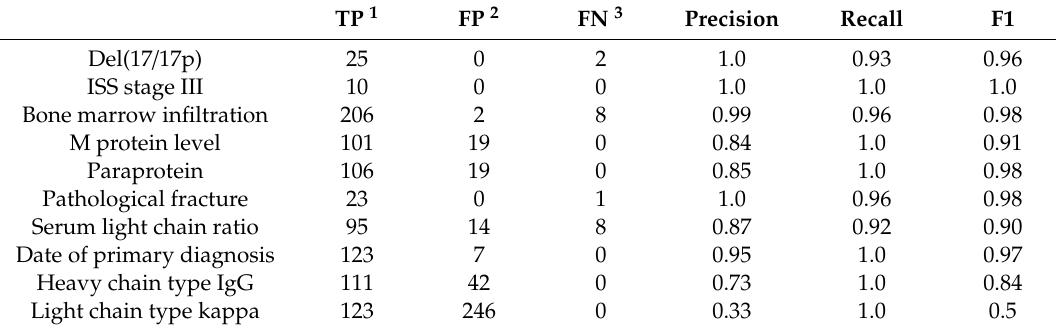
Table 3. Detailed results for selected MM-specific